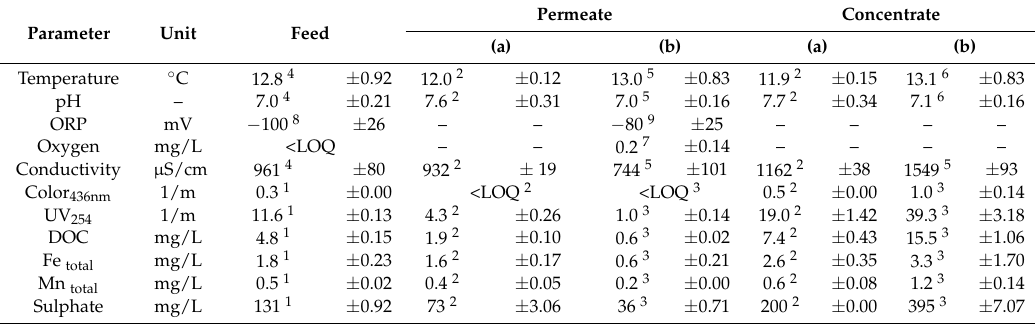
Table A1. Water quality feed, permeate, and concentrate; feed: well water.